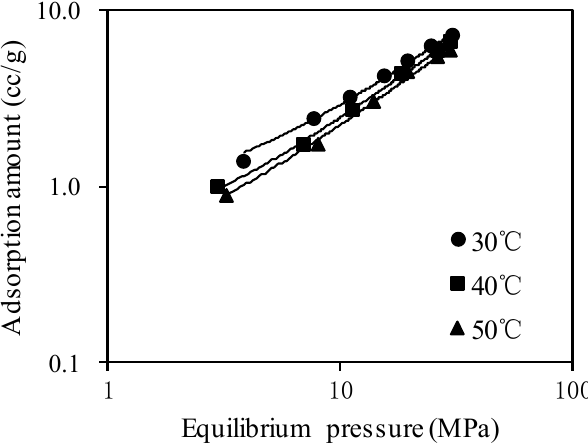
Figure 11. Adsorption amount versus equilibrium pressure at different temperature.